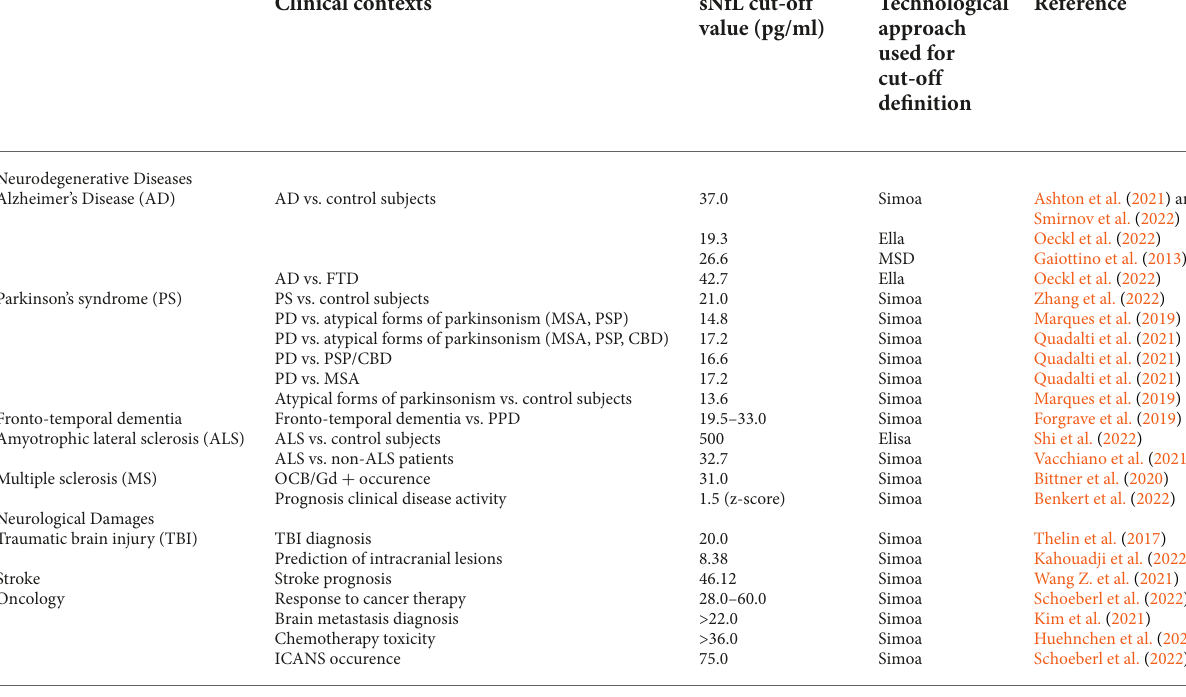
TABLE 1 Diagnostic/prognostic blood NfL’s threshold in neurological pathological context, according to various technological